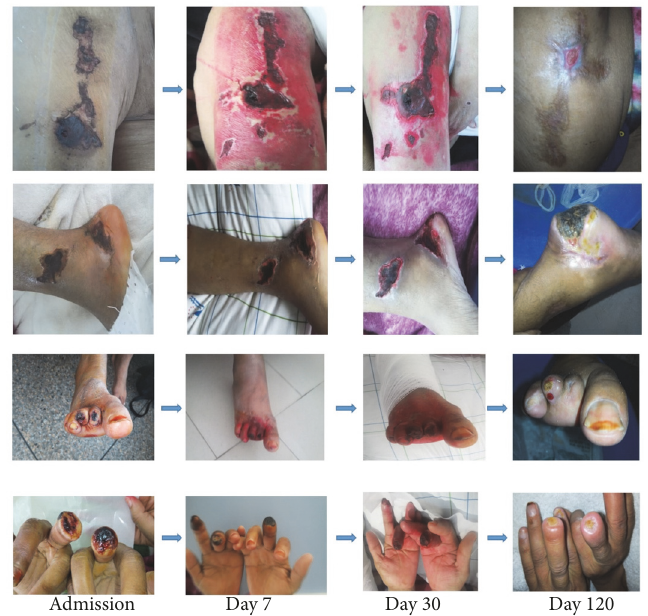
Figure 2: Evolution of Calciphylaxis lesions over 4 months of treatment in patient 1. Necrosectomy could not be performed at the heels because of the risk of injury to the Achilles tendon.